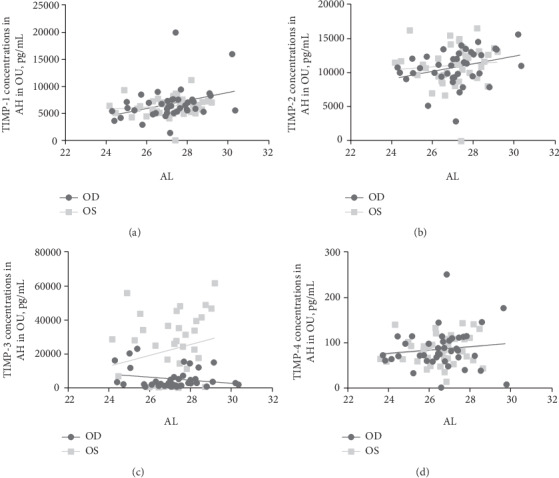
Scatter plots of concentrations of TIMP-1 (a), TIMP-2 (b), TIMP-3 (c), and TIMP-4 (d) levels in the aqueous humor. The right eye (OD) and left eye (OS) were marked differently.